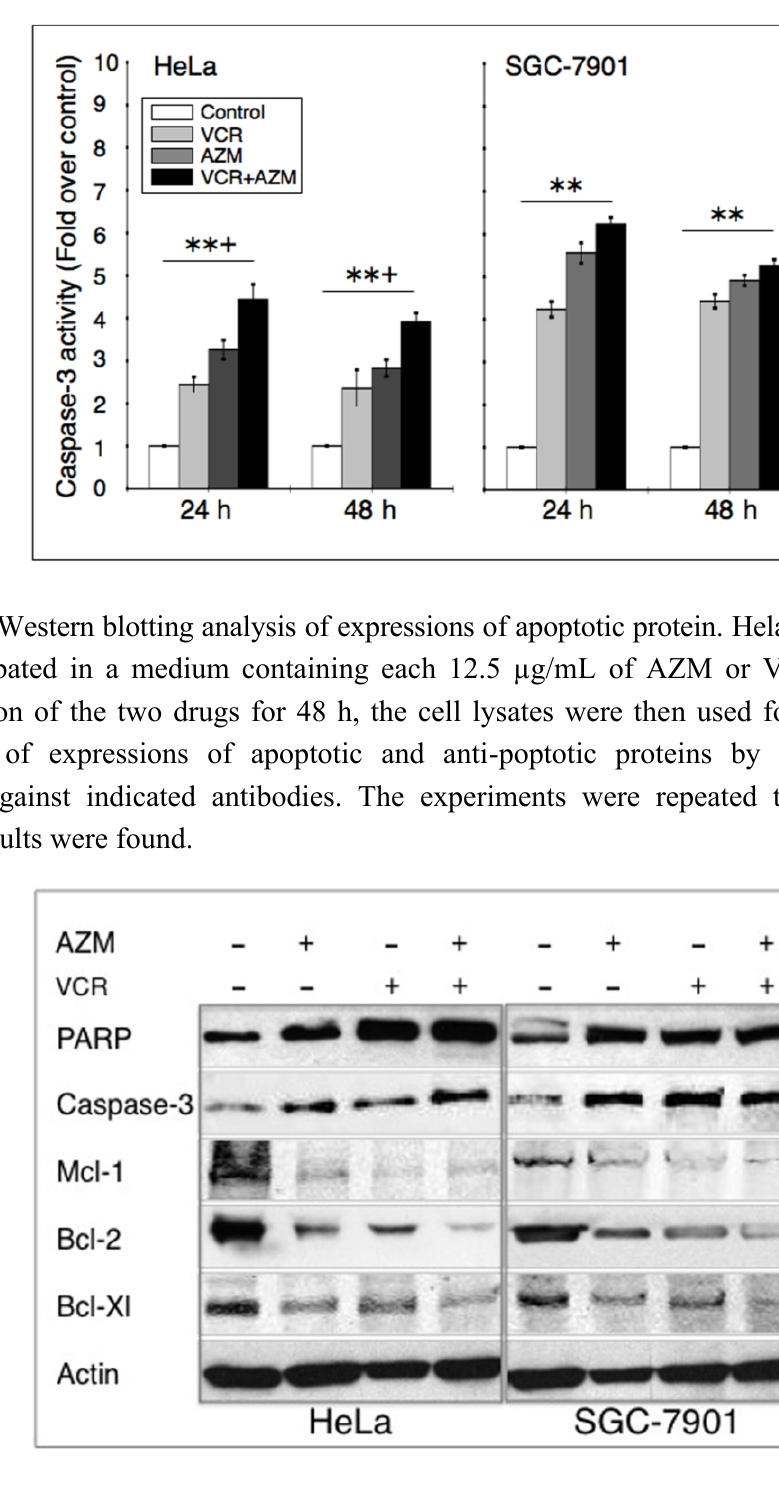
Figure 4. Effect of AZM or VCR on caspase-3 activity in cancer cells. Hela and SGC-7901 cells were treated with 12.5 µg/mL of each AZM or VCR alone, or a combination of the two agents for 24 and 48 h, the cell lysates were then employed for determining caspase-3 activity. Values represents fold of activity over the control lysates. The data express the mean (±SD) of nine samples from three independent experiments for each condition (N = 9). Compared with medium control, **: p < 0.01; compared with each of AZM or VCR alone, + : p < 0.05.